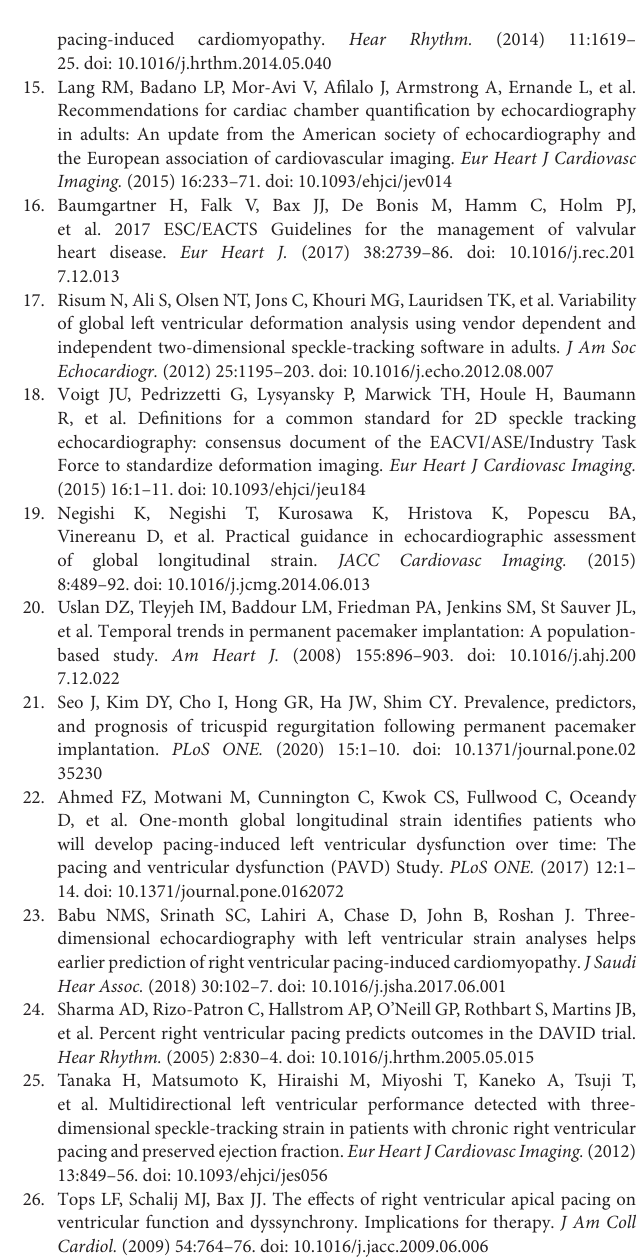
Supplementary Table 1 | Multiple linear regression analysis for post-PM |LV-GLS| and |Apical septal strain|. |LV-GLS|, absolute value of left ventricular global longitudinal strain; |Apical septal strain|, absolute value of left ventricular apical septal strain; RV, right ventricle; HTN, hypertension; DM, diabetes mellitus.